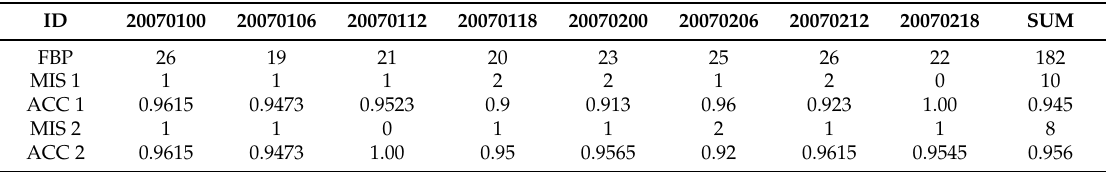
Table 2. Accuracy analysis results with eight groups of data in 2007. FBP is the element number in the potential cyclone eye set; MIS indicates the number of identification